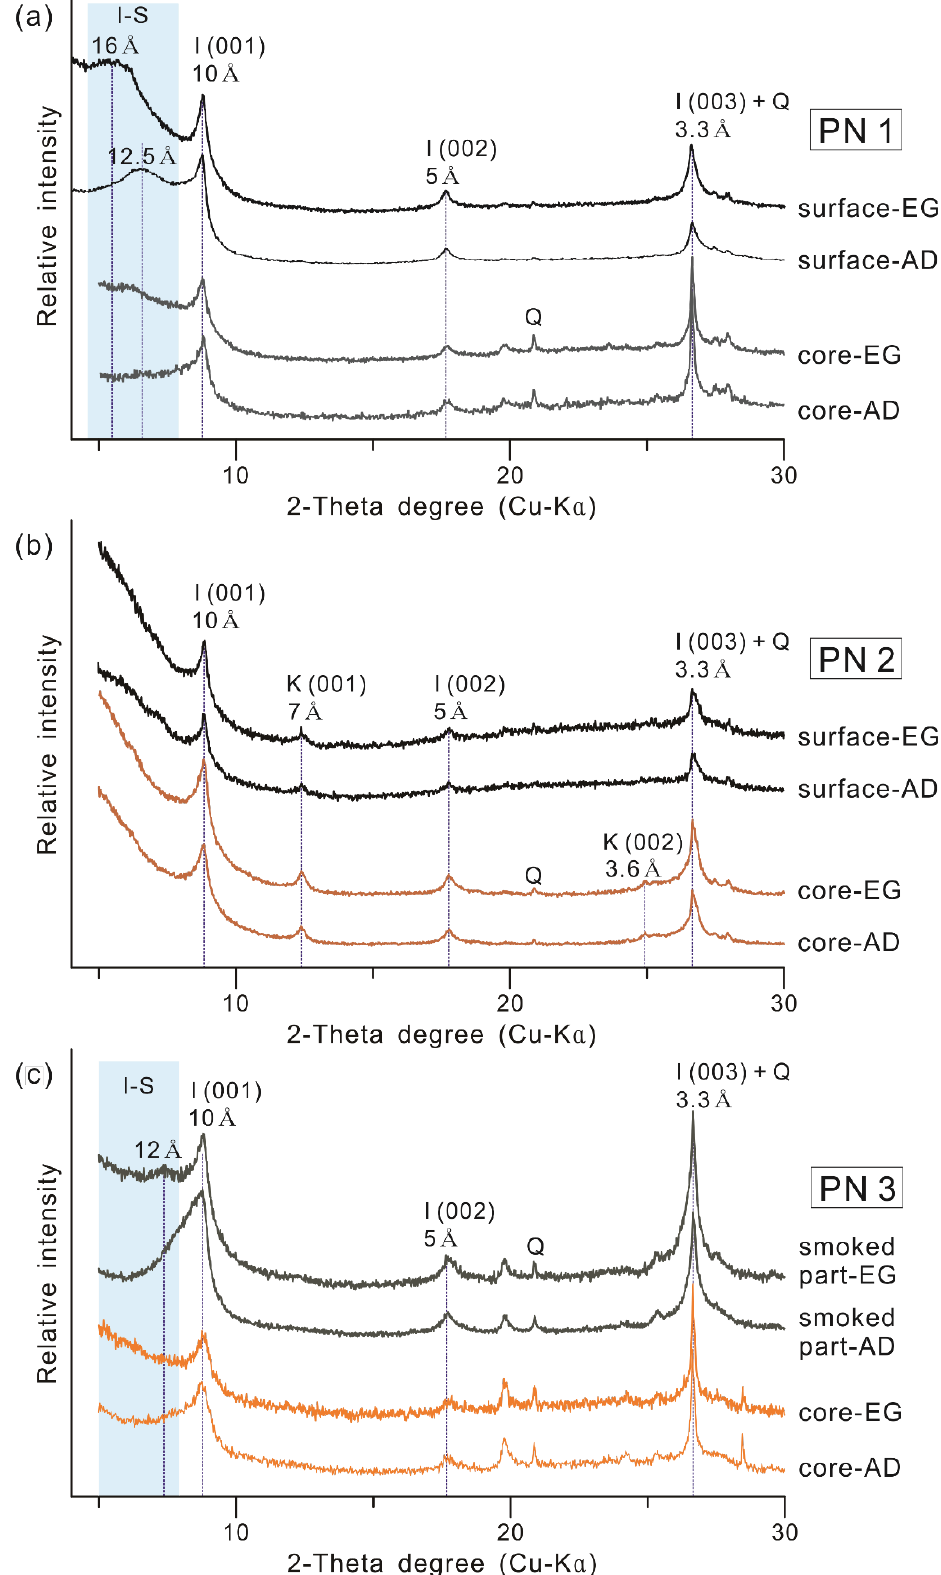
Figure 4. X-ray diffraction patterns of the oriented specimens of clay particles (AD: air-dried, EG: ethylene glycol saturated, I: illite, I – S: illite – smectite mixed layer, K: kaolin, Q: quartz, Blue shaded zone: the diffraction range of the expandable layer by the I – S.): ( a ) PN1, ( b ) PN2, and ( c ) PN3.